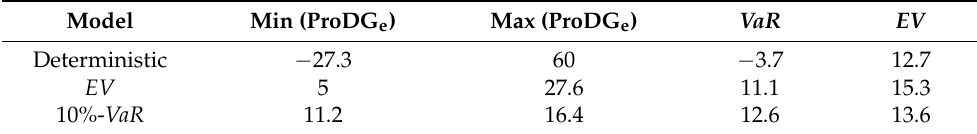
Table 2. Risk indicators (k£/year) using different approaches.